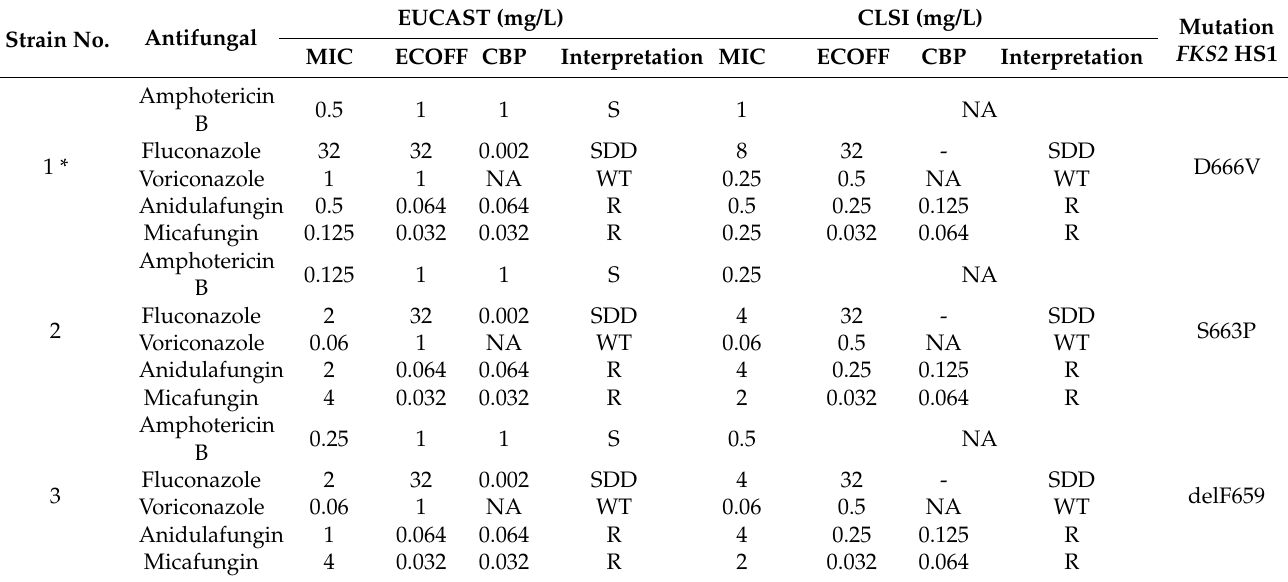
Table 1. The results of the antifungal susceptibility testing with the EUCAST and CLSI reference methods and FKS mutations for the echinocandin-resistant Candida glabrata isolates reported in this article. Strain